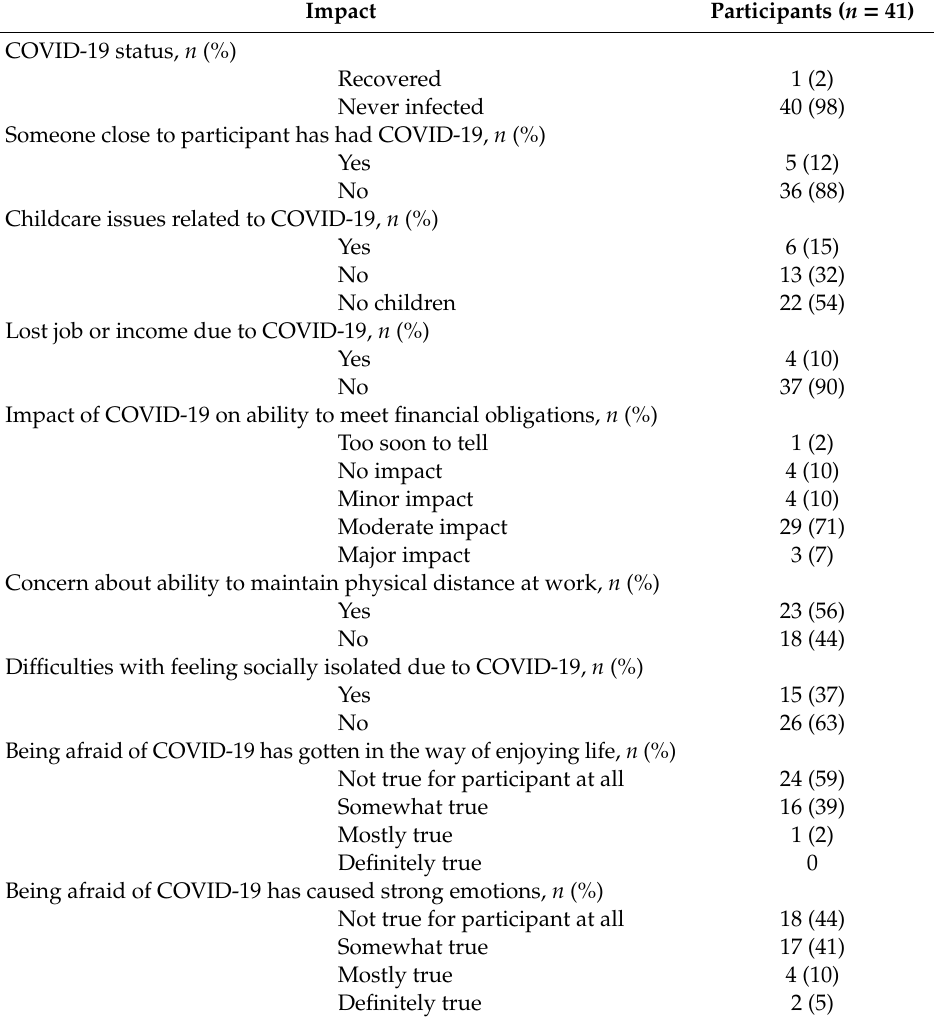
Table 3. Results of COVID-19 Questionnaire items concerning impacts of COVID-19.